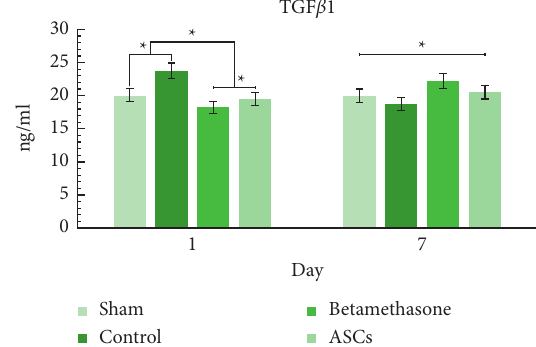
Figure 7: TGF- β 1 concentration of rat skin in sham, control, betamethasone, and ASC groups on days 1 and 7. Error bar: mean ± SD ( ∗ p ≤